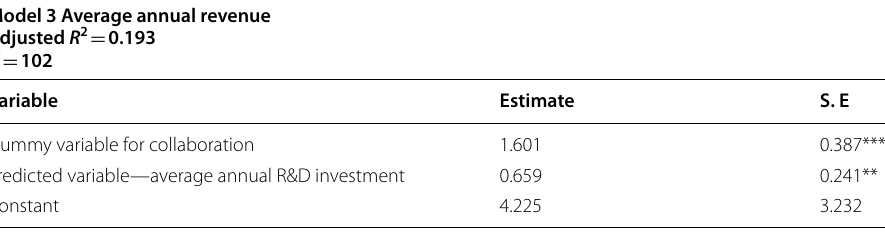
** Level of significance *** Level of significant